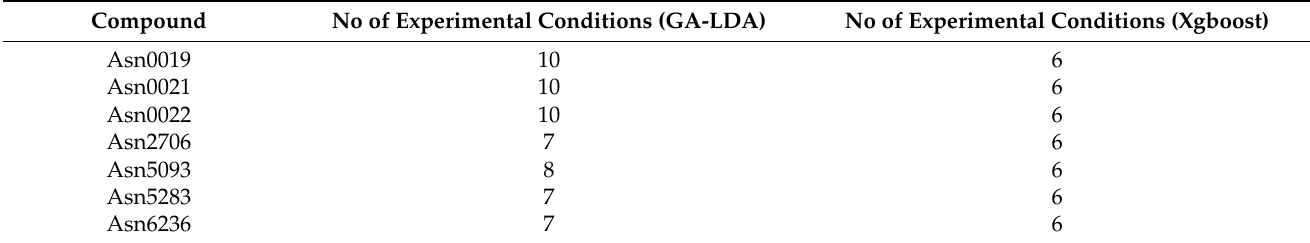
Table 8. Number of experimental conditions pertaining to the most potential virtual hits gathered by the GA ‐ LDA and Xgboost models.